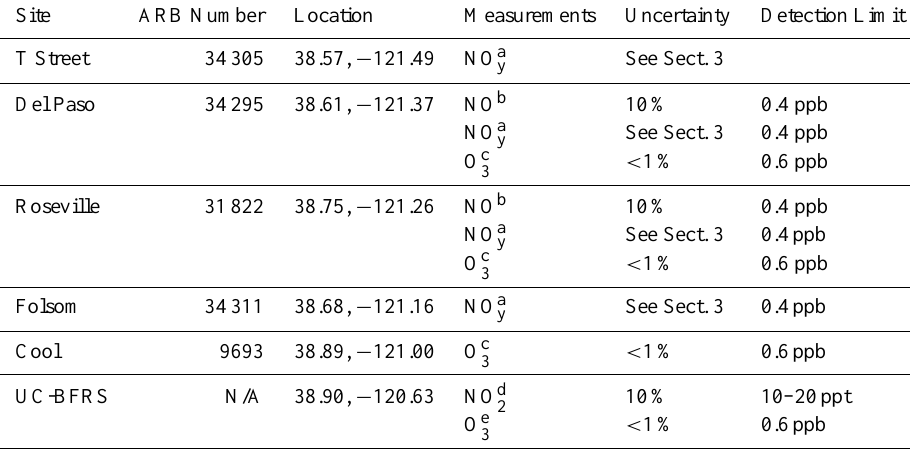
Table 1. Measurement